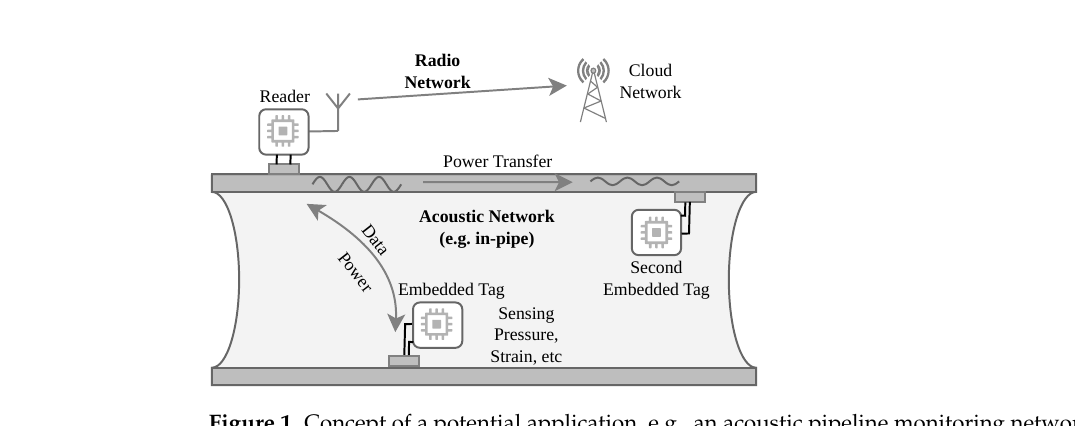
Figure 1. Concept of a potential application, e.g., an acoustic pipeline monitoring network. A reader powers multiple embedded sensor nodes using acoustic-guided